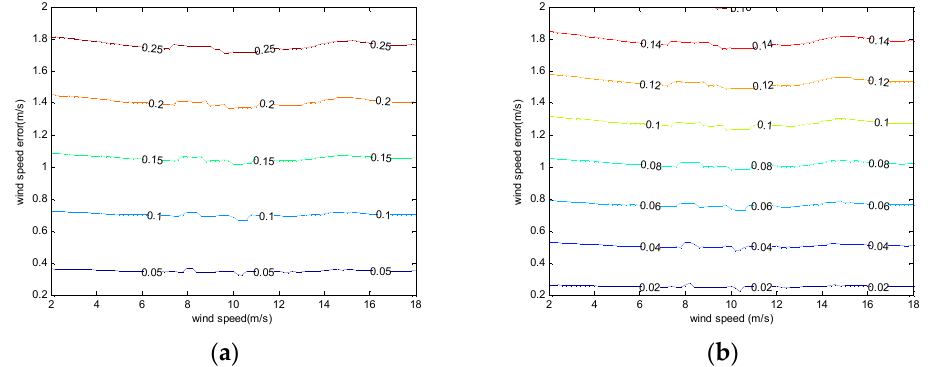
Figure 3. Surface current velocity errors due to different wind speed errors in the downwind direction: ( a ) HH polarization; ( b ) VV polarization.